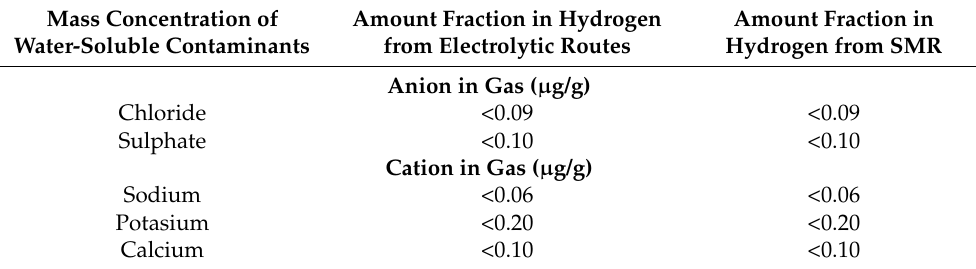
Table 3. Trace water-soluble contaminants from all hydrogen production sources. Mass Concentration of Water-Soluble